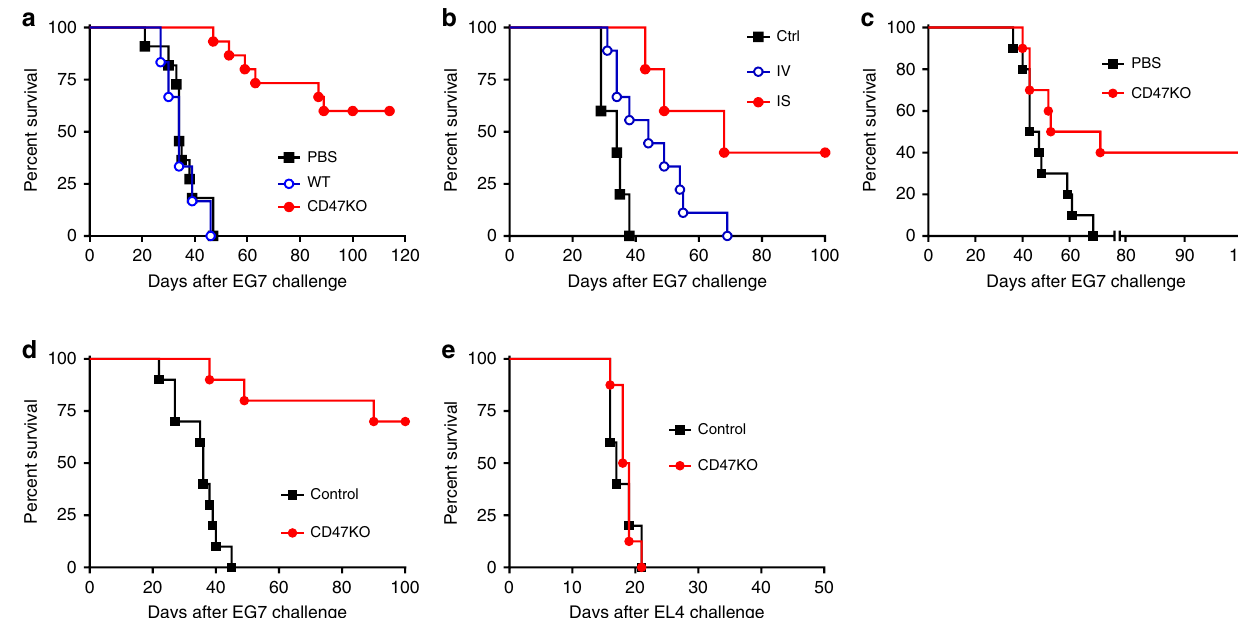
Fig. 2 Injection of OVA-expressing CD47KO cells induces OVA-speci fi c antitumor responses. a C57BL/6 mice received intrasplenic injection of PBS ( n = 11) or splenocytes from WT ( n = 6) or CD47KO ( n = 15) OVA-Tg C57BL/6 mice, followed 7 days later by injection (i.v.; 2.5 × 10 6 ) of EG7 cells. b C57BL/6 mice received intravenous (i.v.; n = 9) or intrasplenic (i.s.; n = 6) injection of CD47KO OVA-Tg splenocytes, or intrasplenic injection of PBS (Ctrl; n = 5), followed 7 days later by injection (i.v.) of 2.5 × 10 6 EG7 cells. c C57BL/6 mice were pre-inoculated intravenously with 1 × 10 5 EG7 cells, followed 1 day later by injection (i.s.) with PBS ( n = 10) or CD47KO OVA-Tg splenocytes ( n = 10). d , e CD47KO OVA-Tg splenocyte-vaccinated B6 mice that survived fi rst EG7 challenge (CD47KO) were re-challenged (i.v.) with 2.5 × 10 6 EG7 ( n = 10; d ) or EL4 ( n = 8; e ) tumor cells. Controls are age- matched B6 mice challenged with EG7 ( n = 10; d ) or EL4 ( n = 5; e ) tumor cells. Source data are provided as a Source Data fi